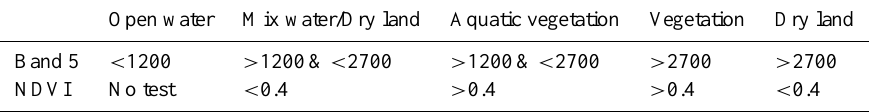
Table 1. Threshold values used for the classification surface type used to monitor flood events. Band unit of reflectance is internal HDF-EOS data format specific to the Modis data and do not correspond to usual reflectance